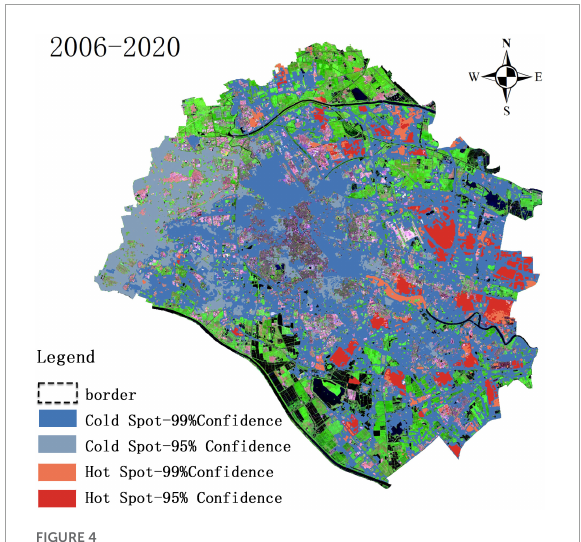
FIGURE4 Distribution of cold and hot spots of health risk posed by high temperatures during